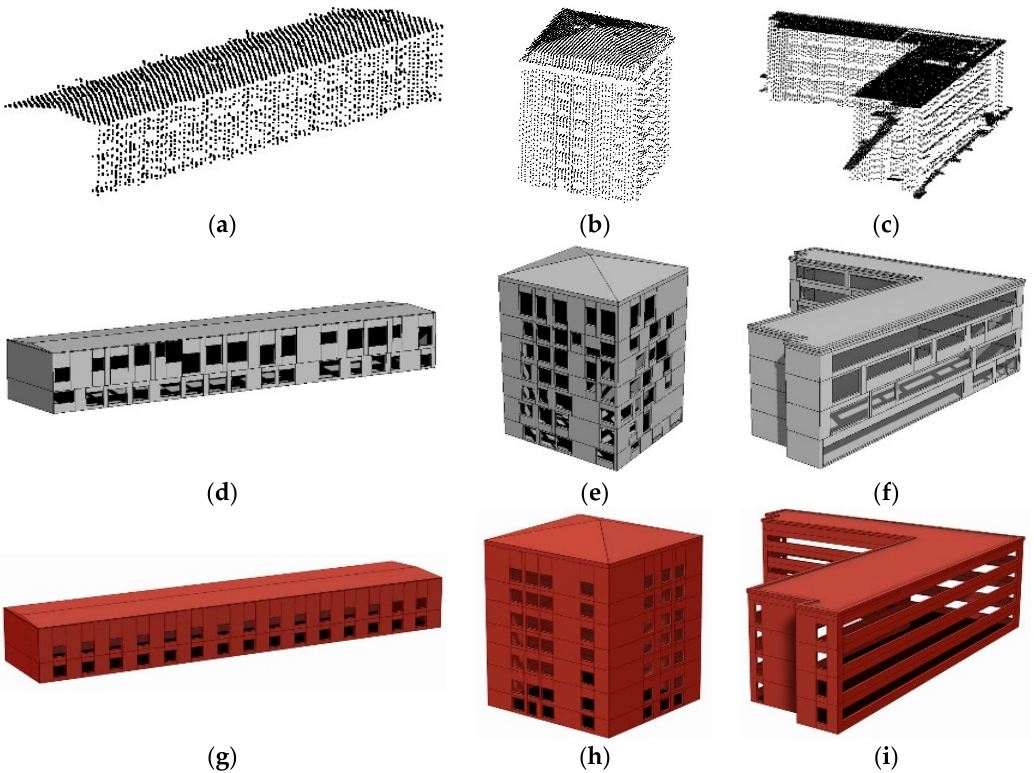
Figure 15. Reconstruction result: ( a – c ) three selected datasets; ( d – f ) reconstruction results of the three buildings; and ( g – i ) rReconstruction models after editing their XBML code.